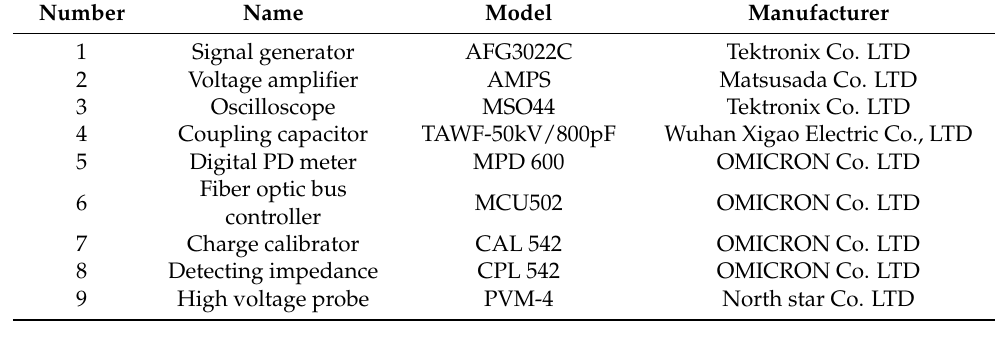
Table 4. Equipment for partial discharge testing.